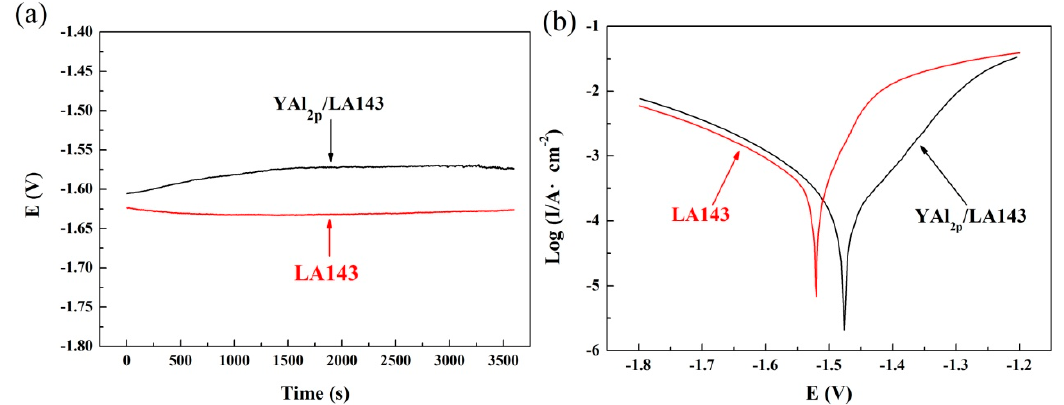
Figure 8. The curves of ( a ) open circuit potential vs time and ( b ) polarization of YAl 2p /LA143 composite and LA143 alloy in 3.5 wt.% NaCl solution.